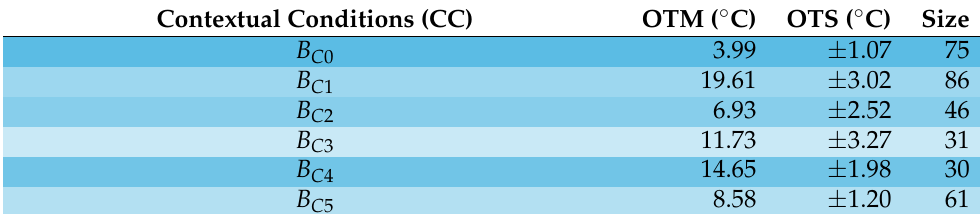
Table 10. Contextual conditions identified after receiving chunk